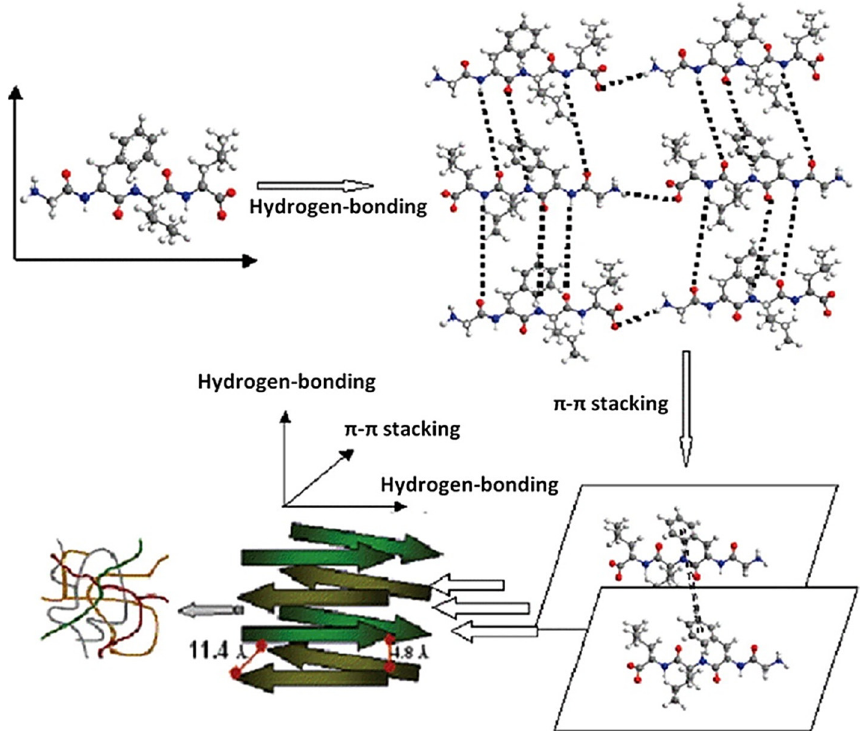
Figure 3. Proposed arrangement of self-assembled peptides (SAP)-based hydrogel from the tetrapeptide (H2N-Gly-Phe-Ile-Leu-COOH) where weak interactions as hydrogen bonding and π - π interactions govern the cross- β structure. Reprinted with permission from Naskar et al. [107]. Copyrights (2020) American Chemical Society.